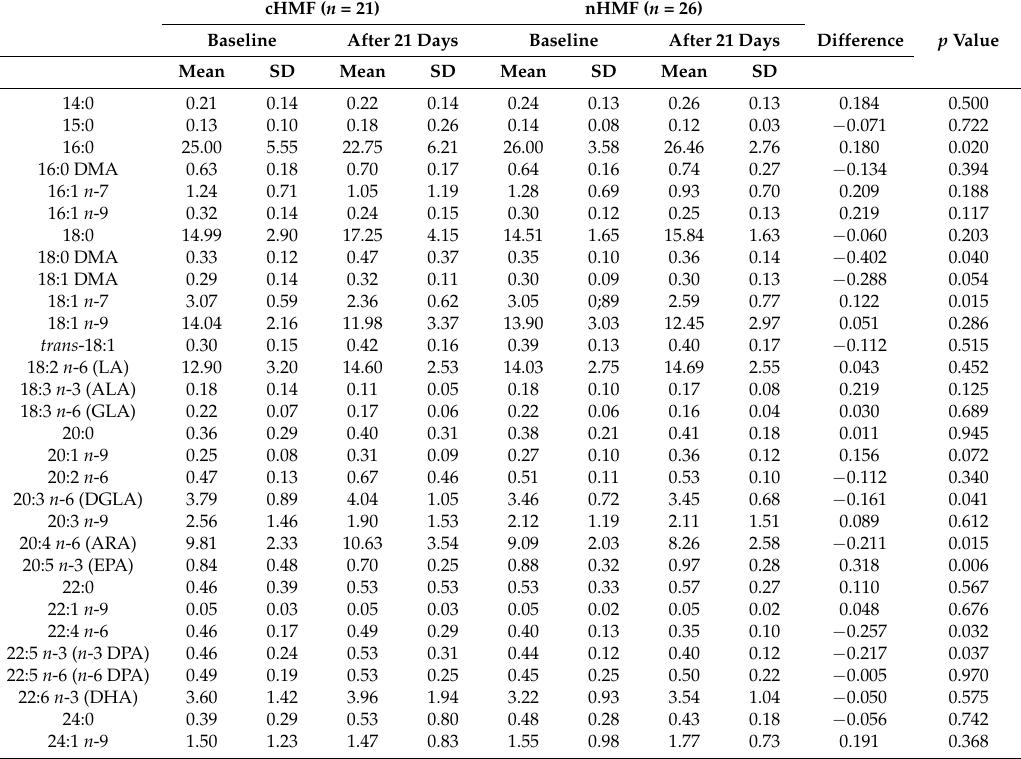
Table 4. Fatty acid profile (g/100 g of fatty acids) of total plasma phospholipids in preterm infants, receiving human milk fortified with a control (cHMF) or with a new human milk fortifier (nHMF) before and after 21 days of treatment. Estimates of the treatment effect nHMF/cHMF (difference) and the two-sided p -values are given for each fatty acid analyzed in the different lipid